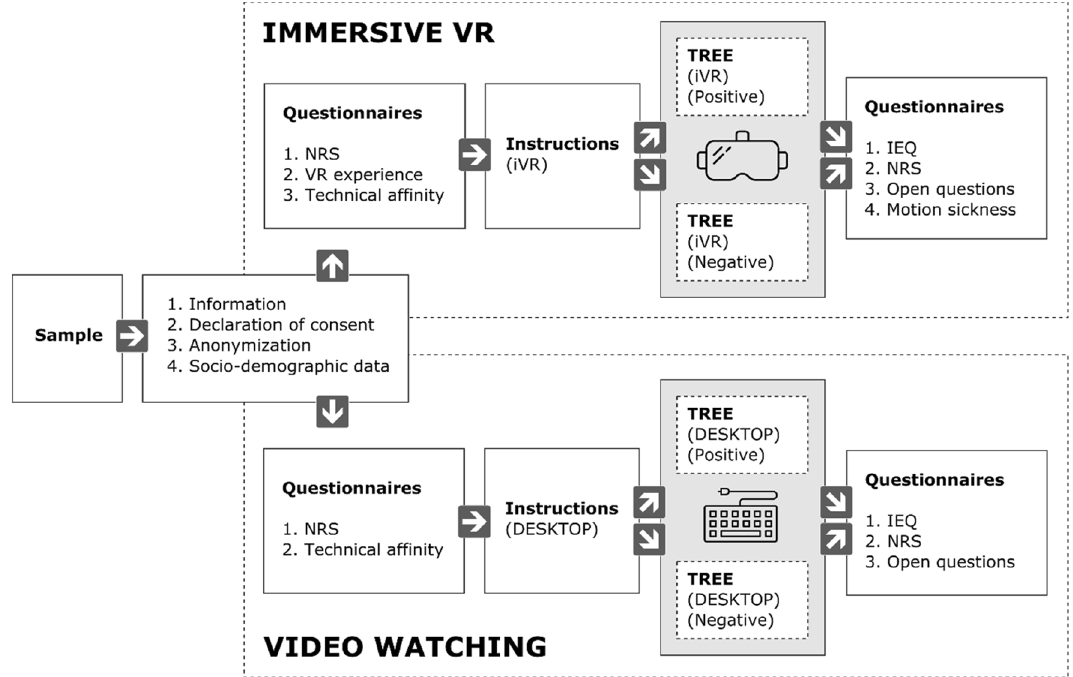
Figure 2. Experimental procedure for the conditions. Own illustration, adapted from final report of students 50 . IEQ = Immersion Experience Questionnaire; NRS = Nature Relatedness